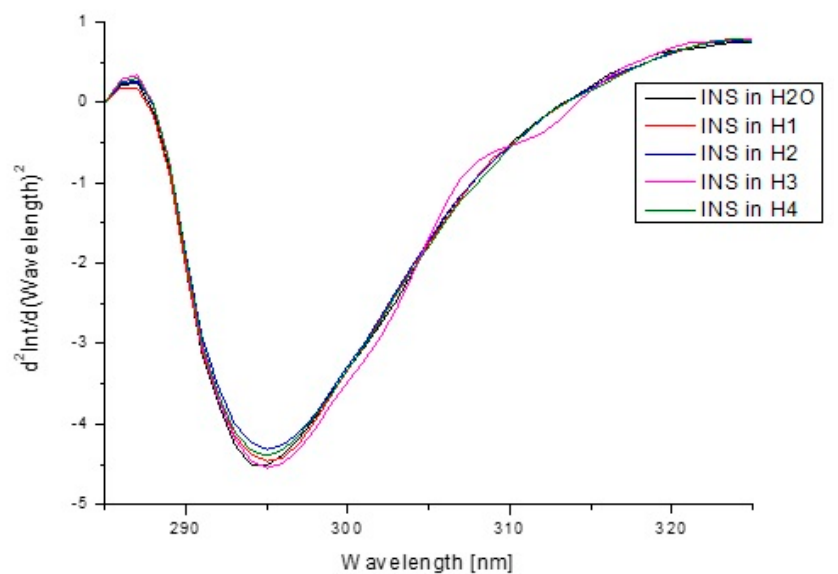
Figure 10. Second derivative emission fluorescence spectra of insulin in H 2 O and in model hydrogels (H1-H4).